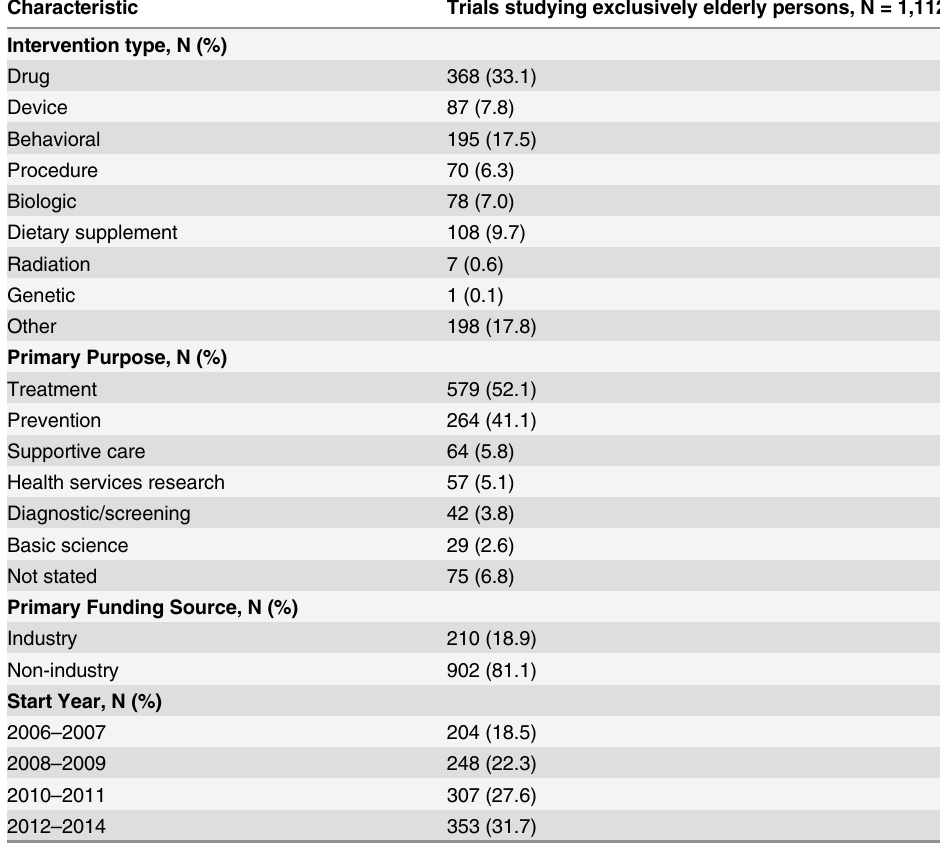
Table 1. General characteristics of registered interventional trials studying exclusively elderly